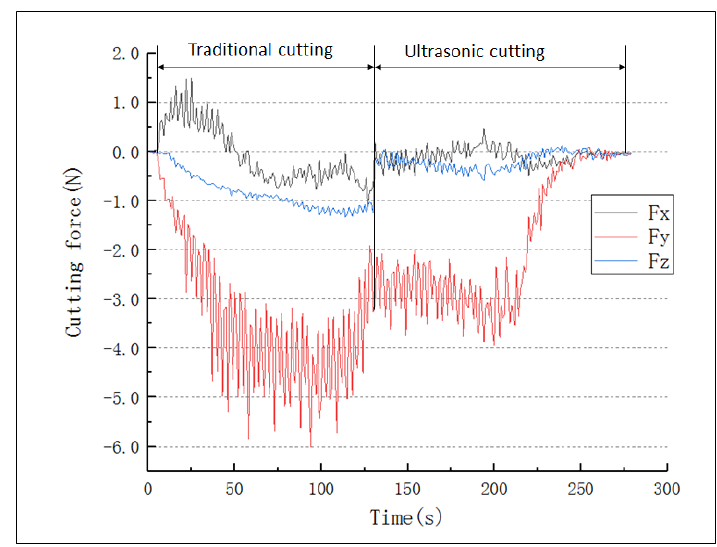
Figure 15. Cutting force under different processing methods.